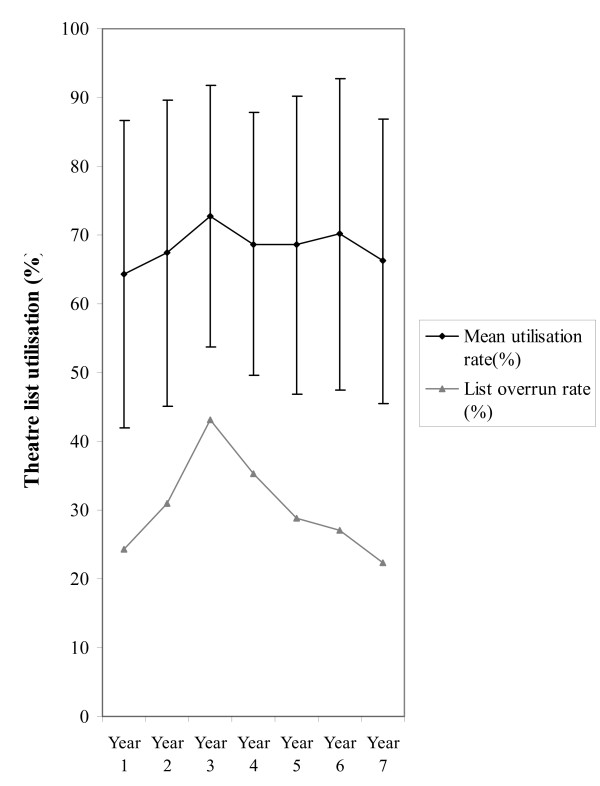
Mean utilization (+SD) and annual overrun rates for day theatre general surgical lists between 1997 & 2004.